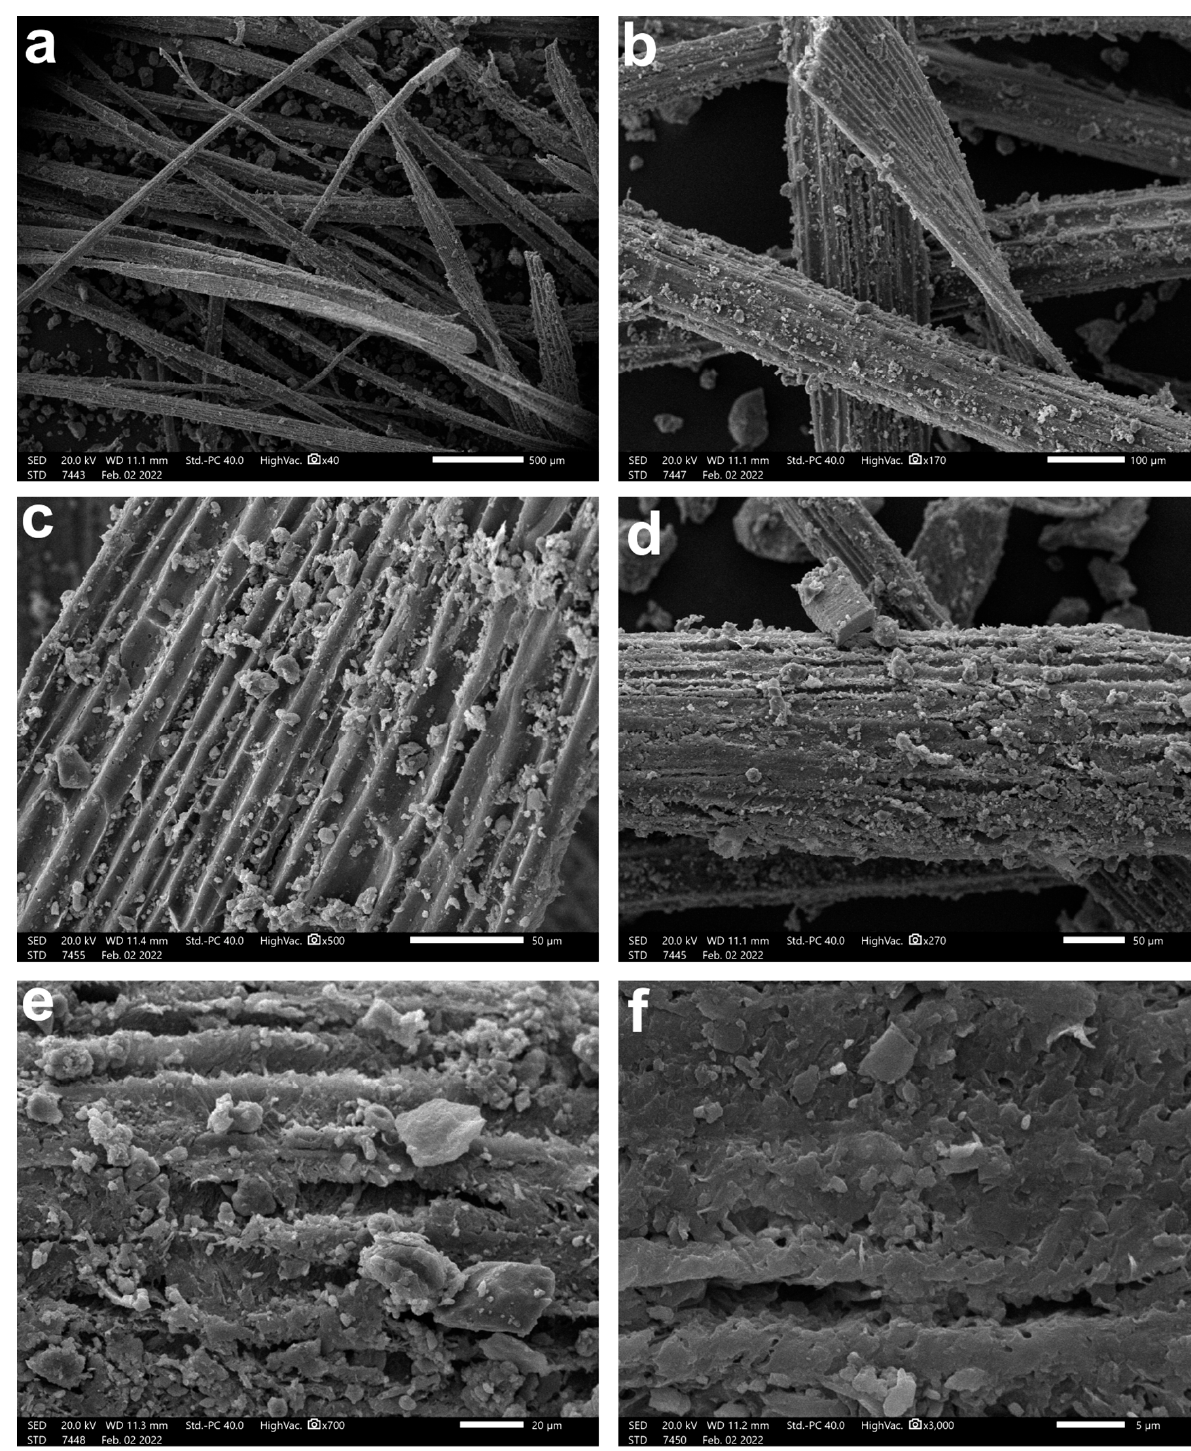
Figure 6. ( a – f ) Back-sca tt ered electron images of Posidonia Oceanic balls(cid:31) morphological